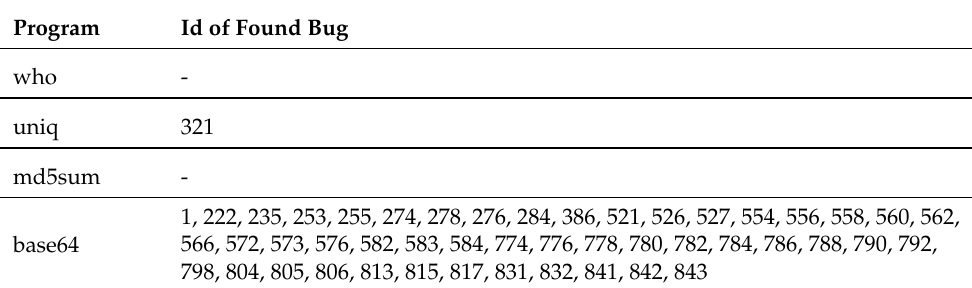
Table 5. List of found bugs by MaxAFL. Each number is unique number that LAVA author